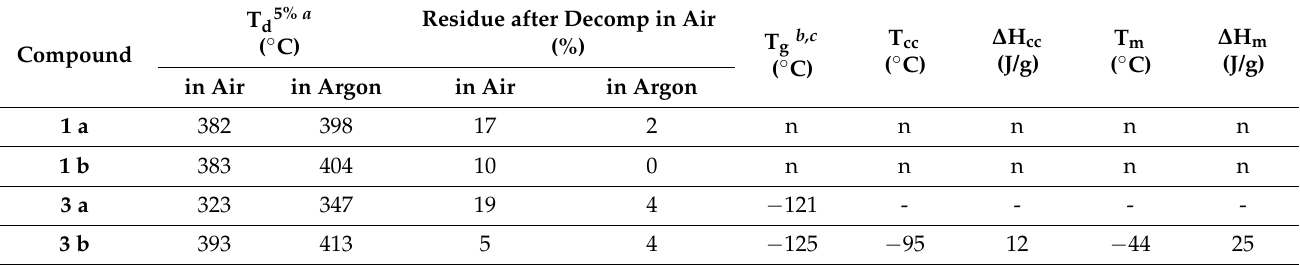
Table 1. Thermal properties of polymers 1 a,b and 3 a,b